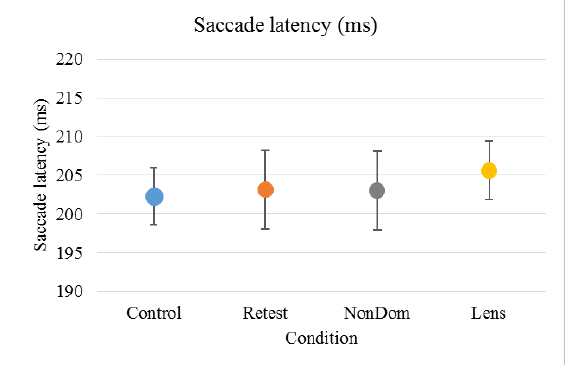
Figure 1. Mean (±standard deviation) saccade latency was 202 (±12) ms for the ‘Control’ condition, 203 (±17) ms for the ‘Retest’ condition, 203 (±17) ms for the ‘NonDom’ con- dition and 206 (±13) ms for the ‘Lens’ condition. Error bars represent the standard